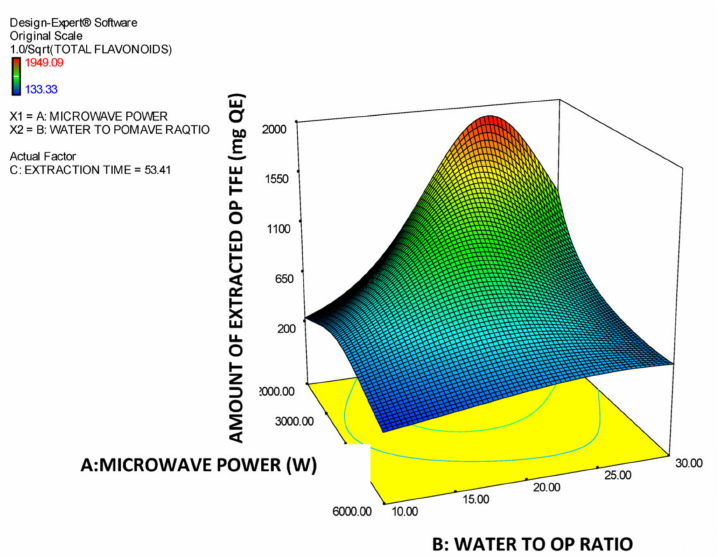
Figure 6. Response surface plot of the amount of extracted total OP flavonoids (TFE in mg QE) for the A × B interaction (A: Microwave power (W); B: Water to OP